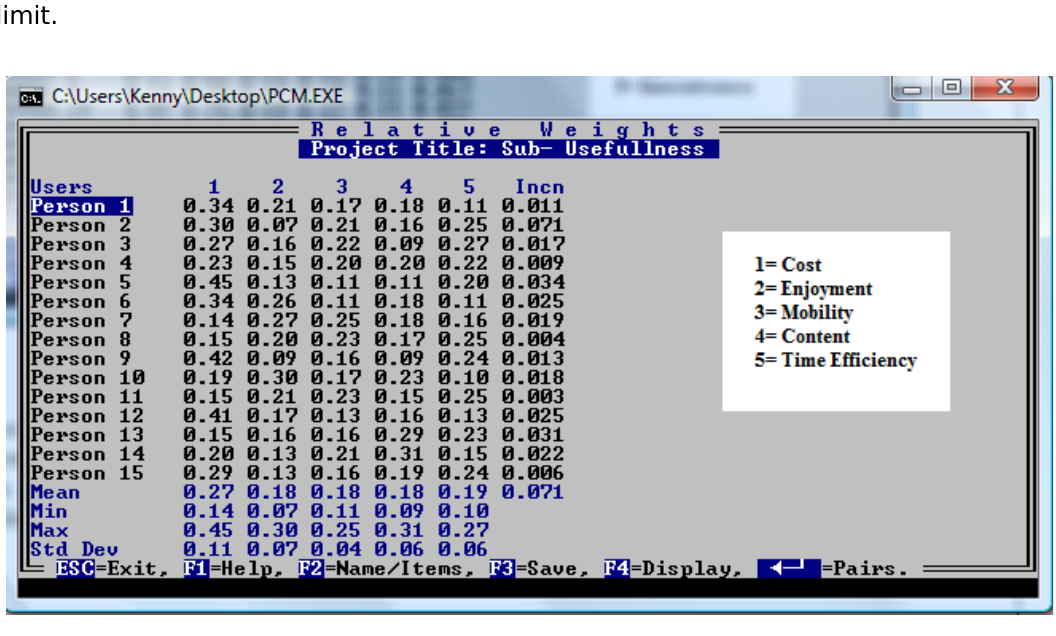
Figure 5. “Sub Criteria –